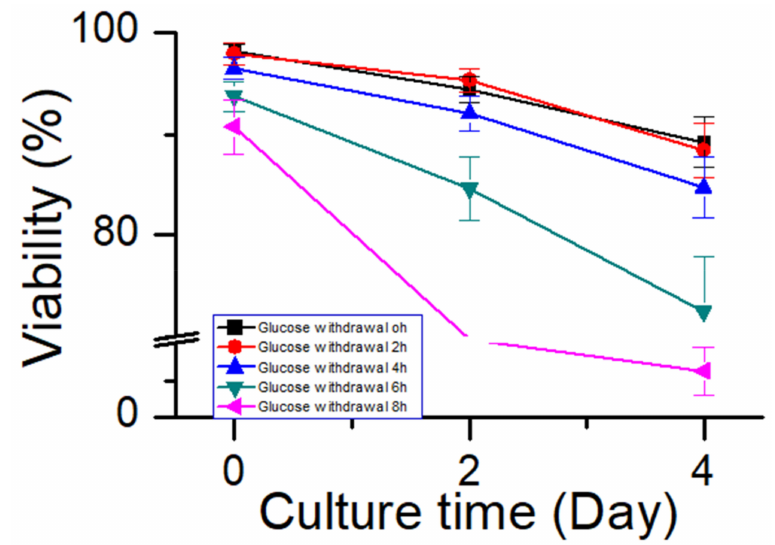
Figure 11. Effect of glucose withdrawal on cell viability in process 2. Data are expressed as mean ± standard error of three